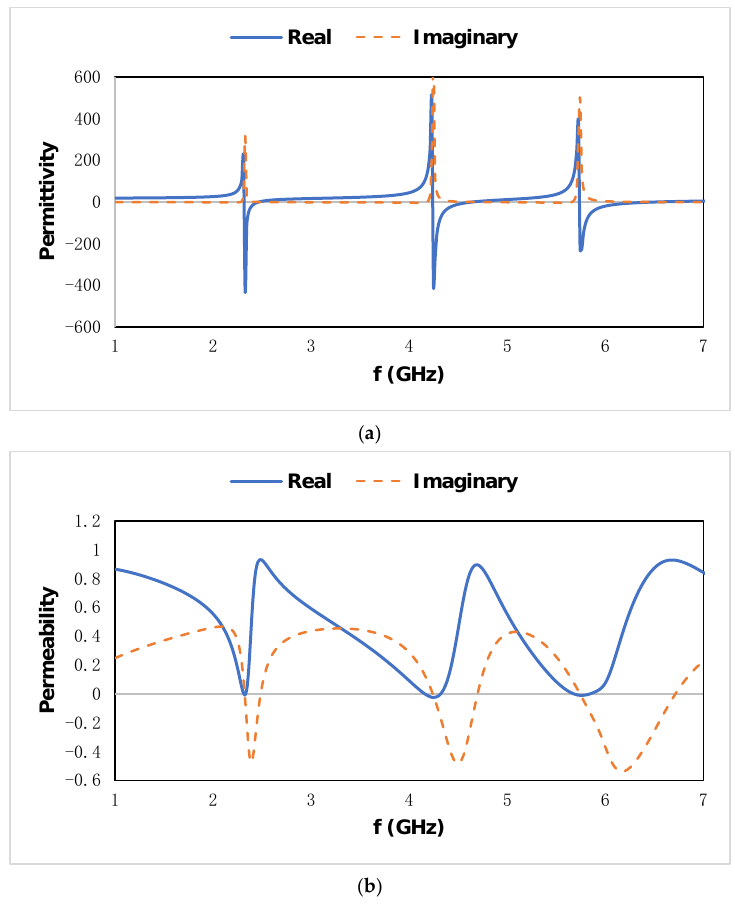
Figure 8. The effective properties of ( a ) effective permittivity; and ( b ) effective permeability of the proposed metamaterial unit